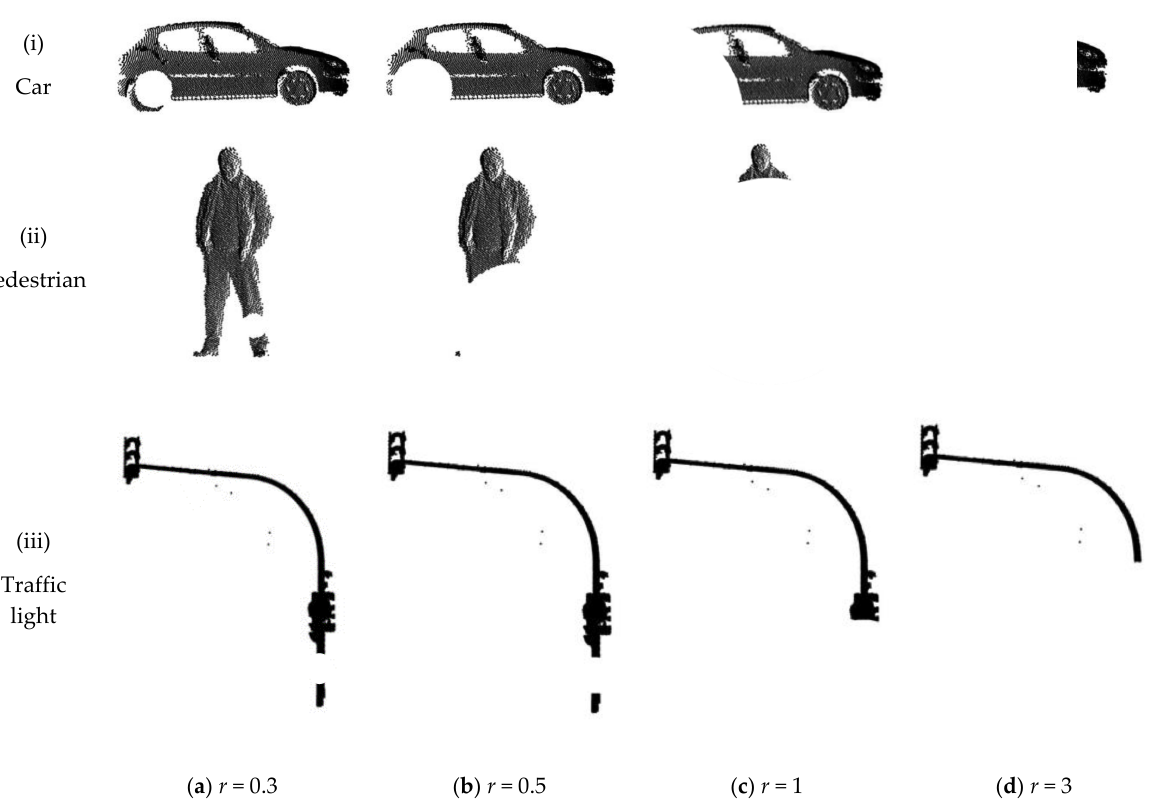
Figure 8. Images generated with occlusions of different sizes.